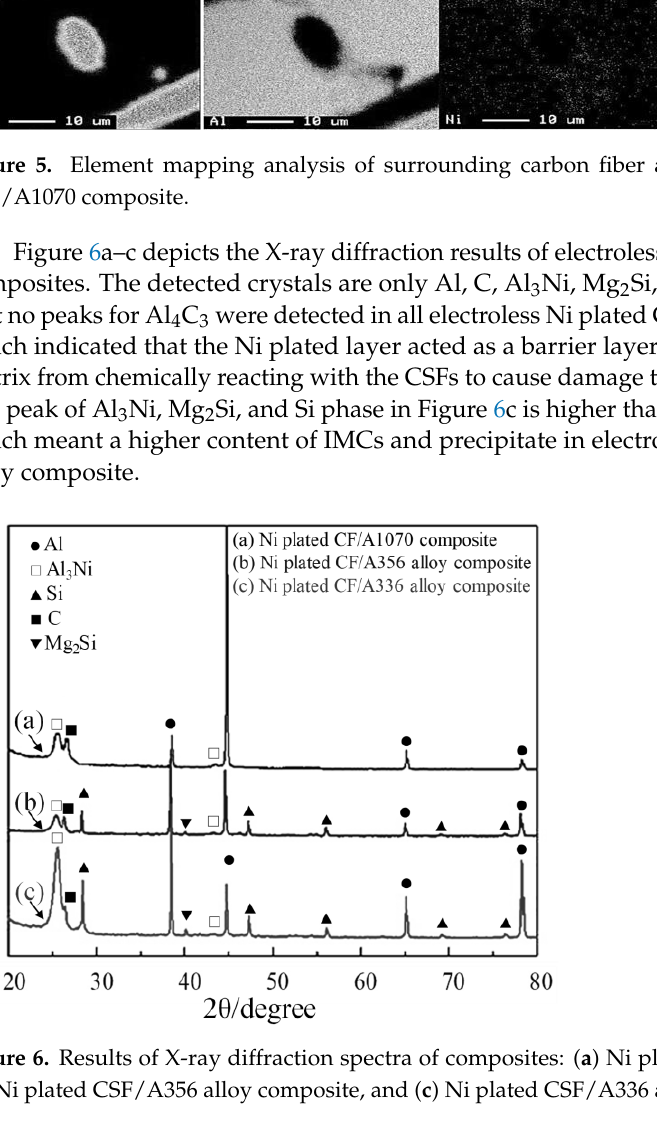
Figure 5. Element mapping analysis of surrounding carbon fiber and Al matrix in Ni plated CSF/A1070 composite.